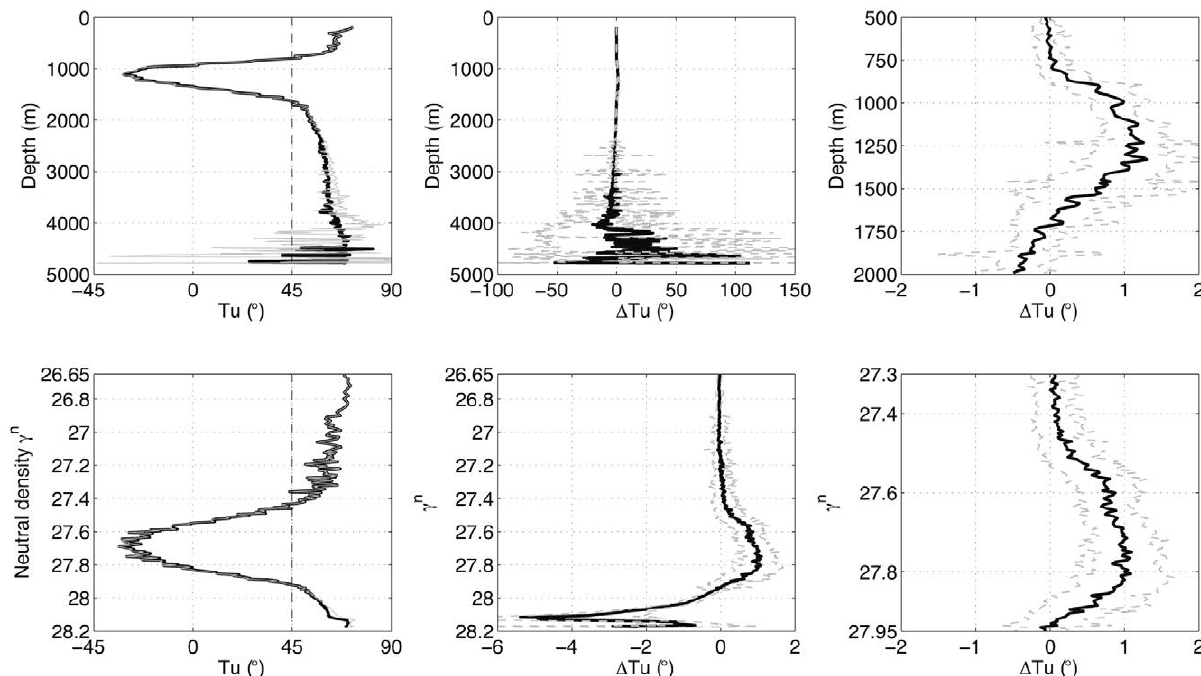
f ig . 5. – Comparison of the classical (Eq. 5) and modified (Eq. 6) Turner angle distributions as obtained using the 2010 data set. The upper panels show the results in the depth domain and the lower panels show them in the neutral density domain. Left panels: mean profiles of Tu (black solid line) and Tu (grey solid line). Middle panels: Turner angle difference according to Equation (7); the mean difference is plotted P with a solid black line whereas the one-standard deviation intervals are dashed in grey. Right panels: as in the middle panels but zooming at the intermediate